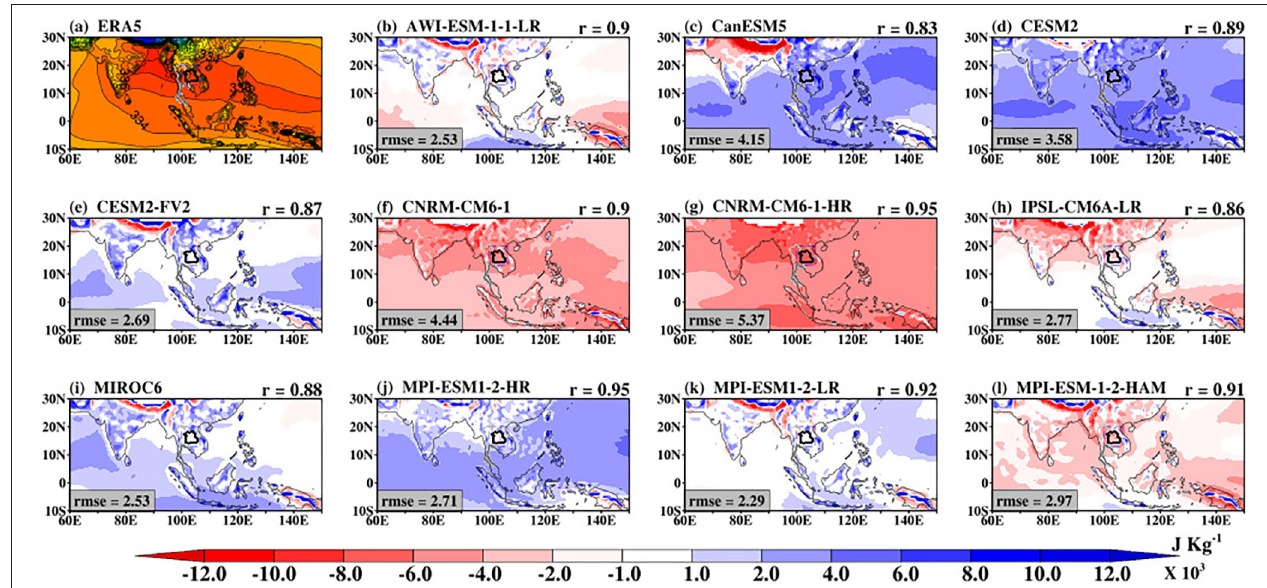
FIGURE 15 | The bias in the simulated monthly mean vertically integrated moist static energy (b–l) with reference to ERA5 (a) during May–October 1997–2014. The mean pattern of ERA5 vertically integrated moist static energy is indicated for reference. The pattern correlation (r) and the root mean squared error (rmse) values between the simulated patterns and that of ERA5 in Supplementary Figure 3 are indicated for